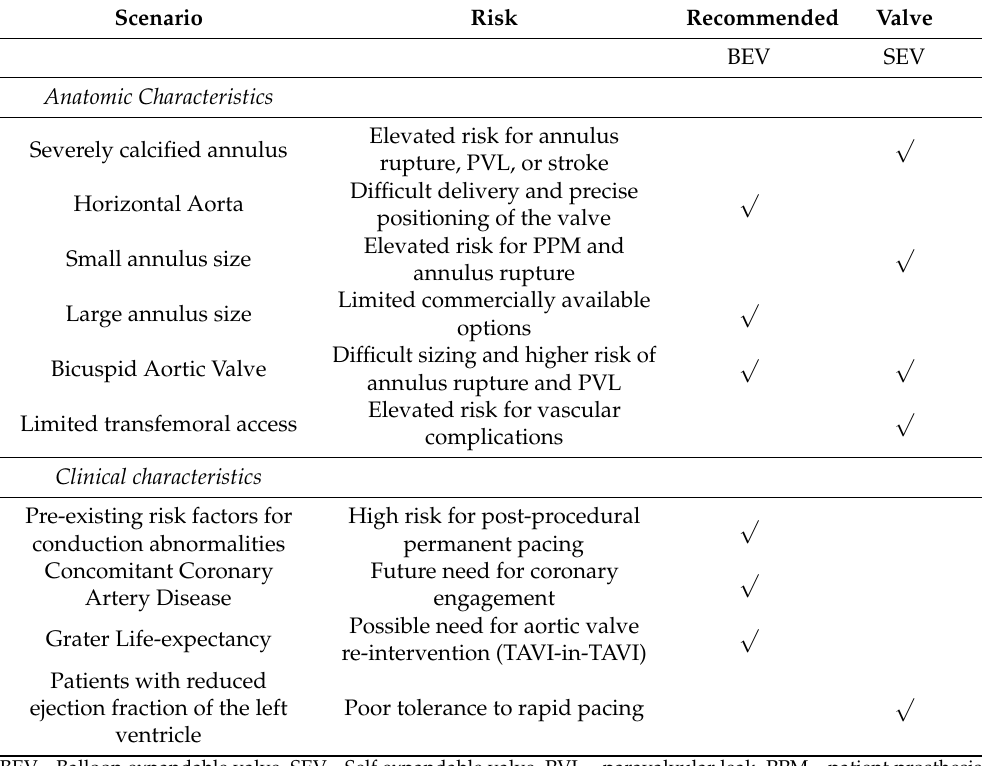
Table 2. Proper device selection based on specific patient anatomic and clinical